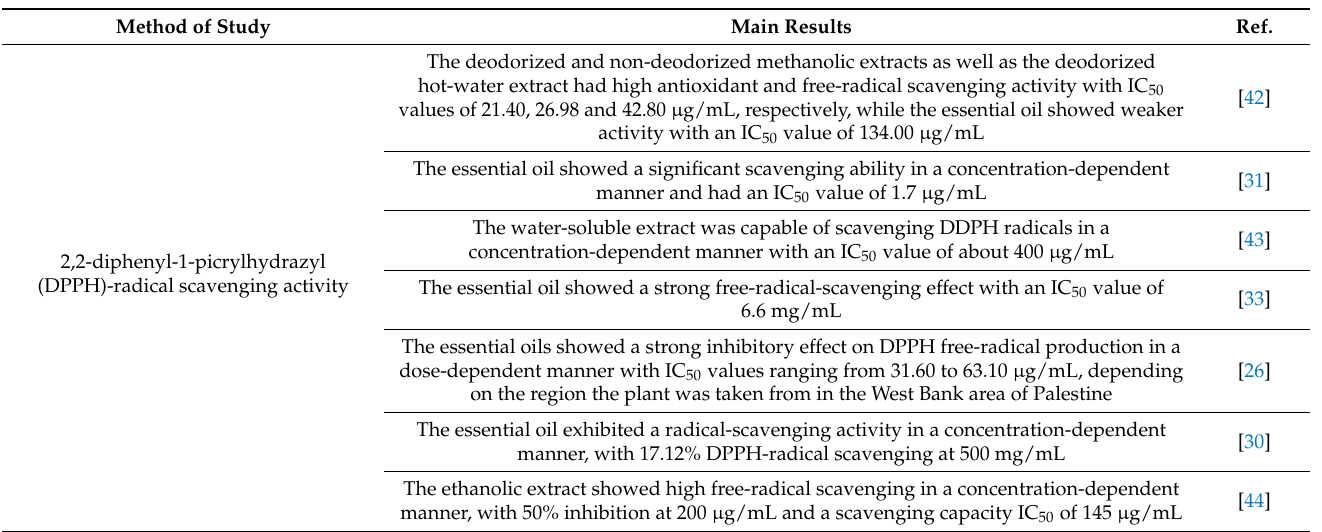
Table 3. Antioxidant activities of Origanum syriacum